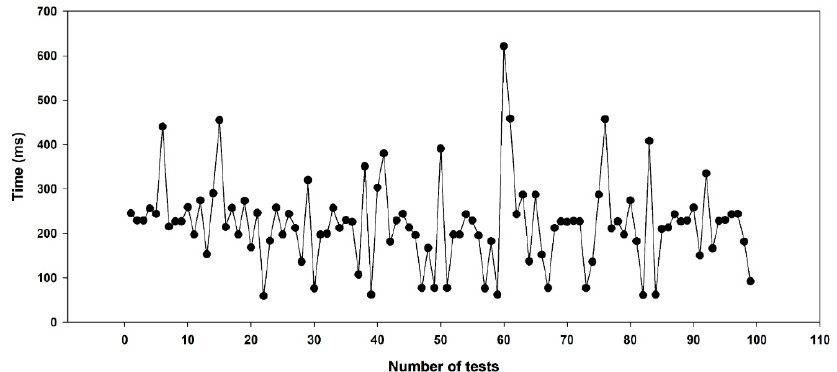
Figure 18. Time latency results of long-distance wireless communication test.